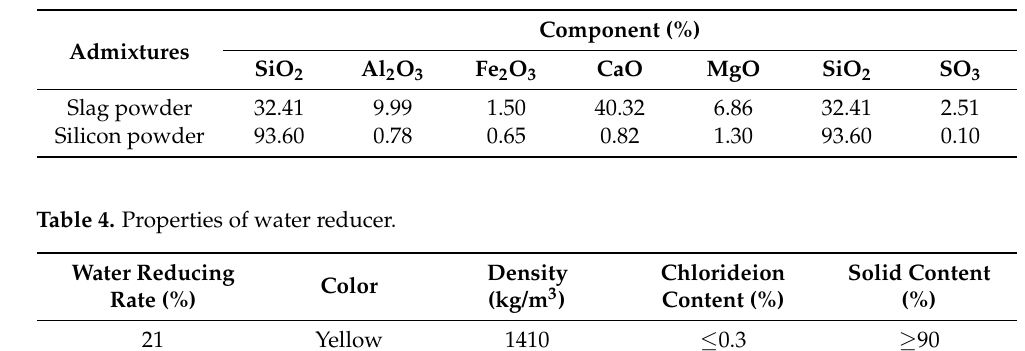
Table 3. Mineral composition of admixture.